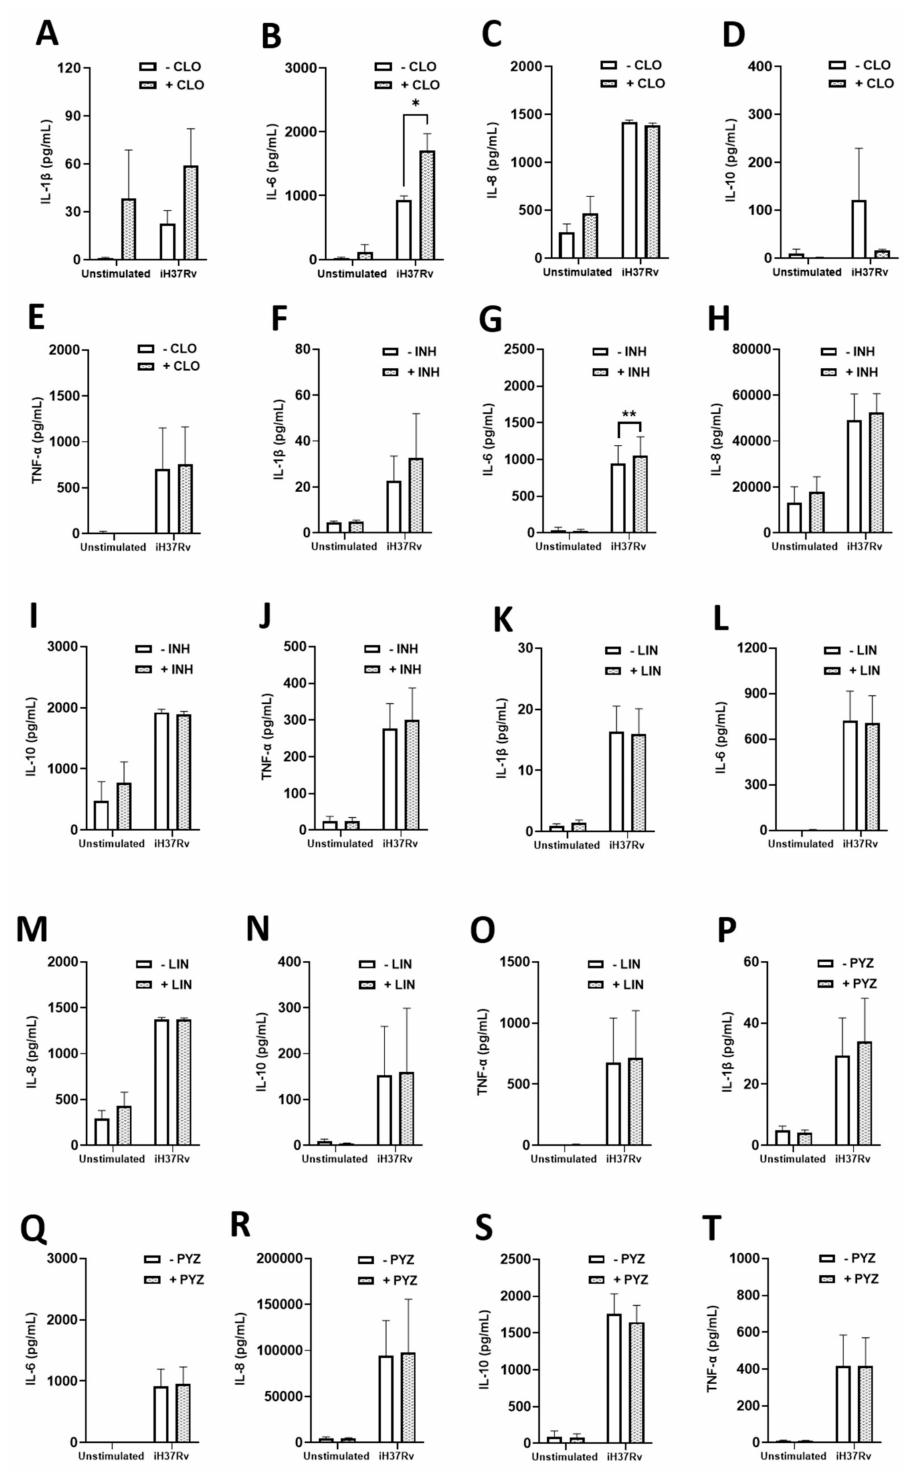
Figure 6. Examining the effect of clofazimine, isoniazid, linezolid and pyrazinamide on protein levels of IL-1 β , IL-6, IL-8, IL-10 and TNF α in hMDMs stimulated with iH37Rv-Mtb. hMDMs, differentiated from PBMCs isolated from healthy blood donors, were stimulated with iH37Rv Mtb for three hours, washed to remove unphagocytosed Mtb, and were treated with clofazimine (2 µ g/mL), isoniazid (1 µ g/mL), linezolid (15 µ g/mL) or pyrazinamide (2 µ g/mL). At 24 h post stimulation, protein levels of IL1 β ( A , F , K and P ), IL-6 ( B , G , L and Q ), IL-8 ( C , H , M and R ), IL-10 ( D , I , N and S ) and TNF α ( E , J , O and T ) were quantified using Meso Scale Discovery Multi-Array technology. Bars denote mean ± SEM. * p < 0.05 (Two-way repeated measures ANOVA tests with Š í d á k’s multiple comparisons